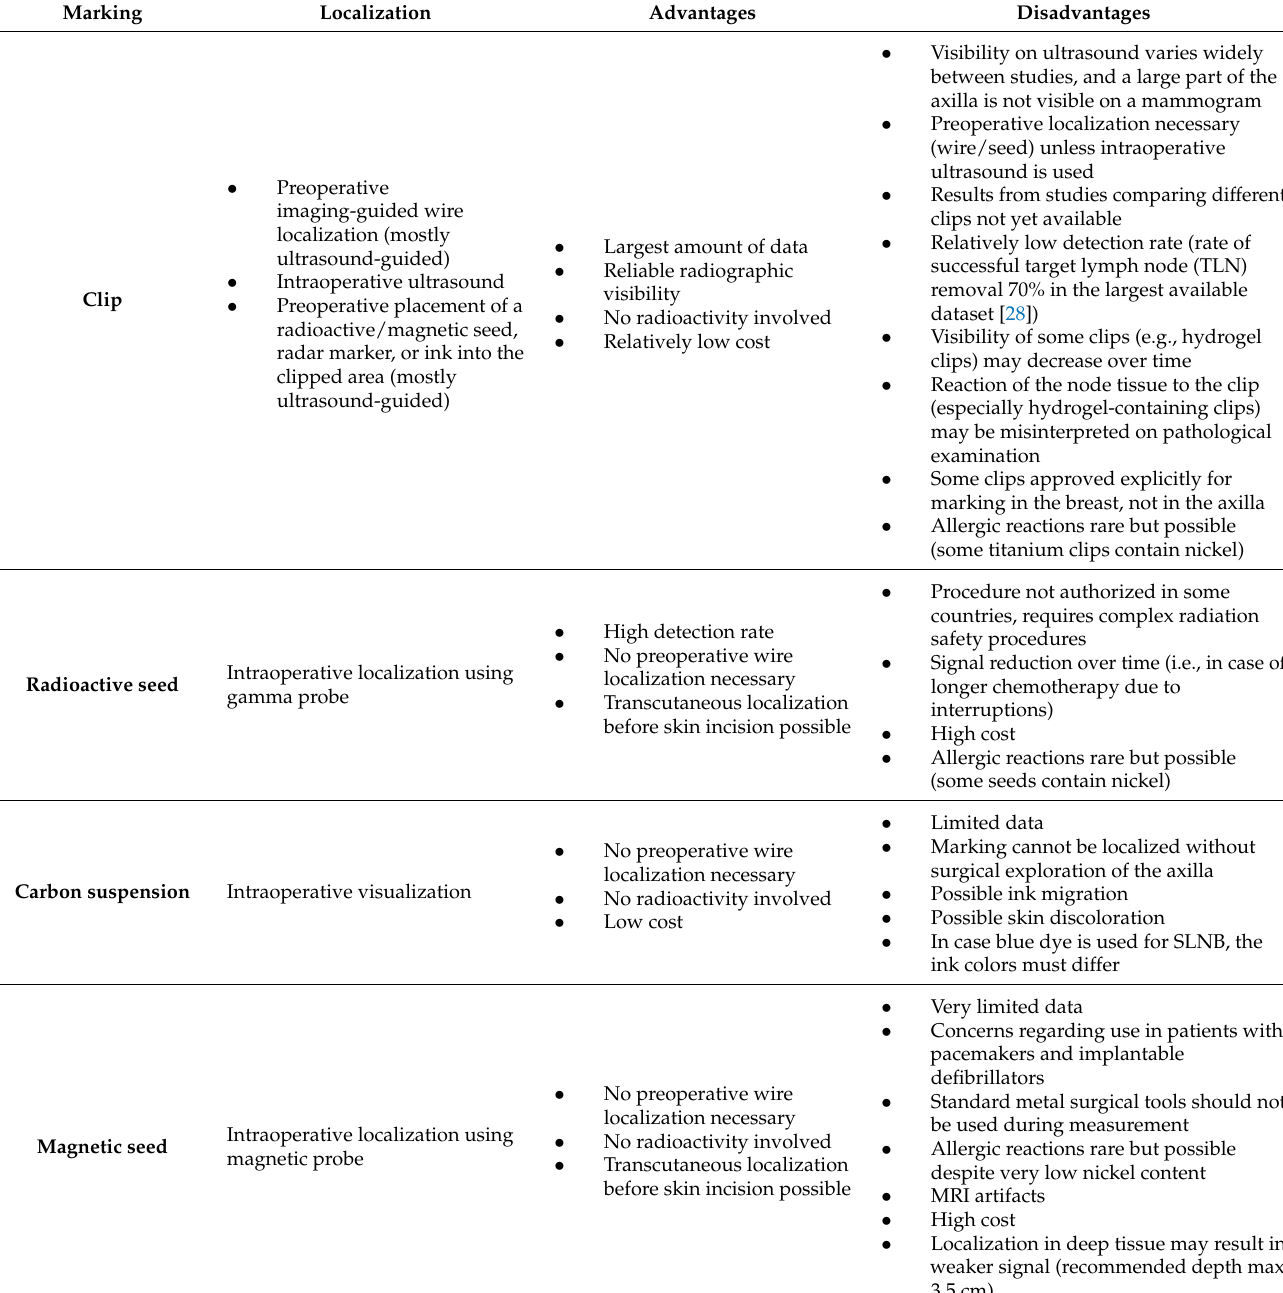
Table 4. Possible options for marking and localizing suspicious lymph nodes prior to start of neoadjuvant chemotherapy (modified after Reference